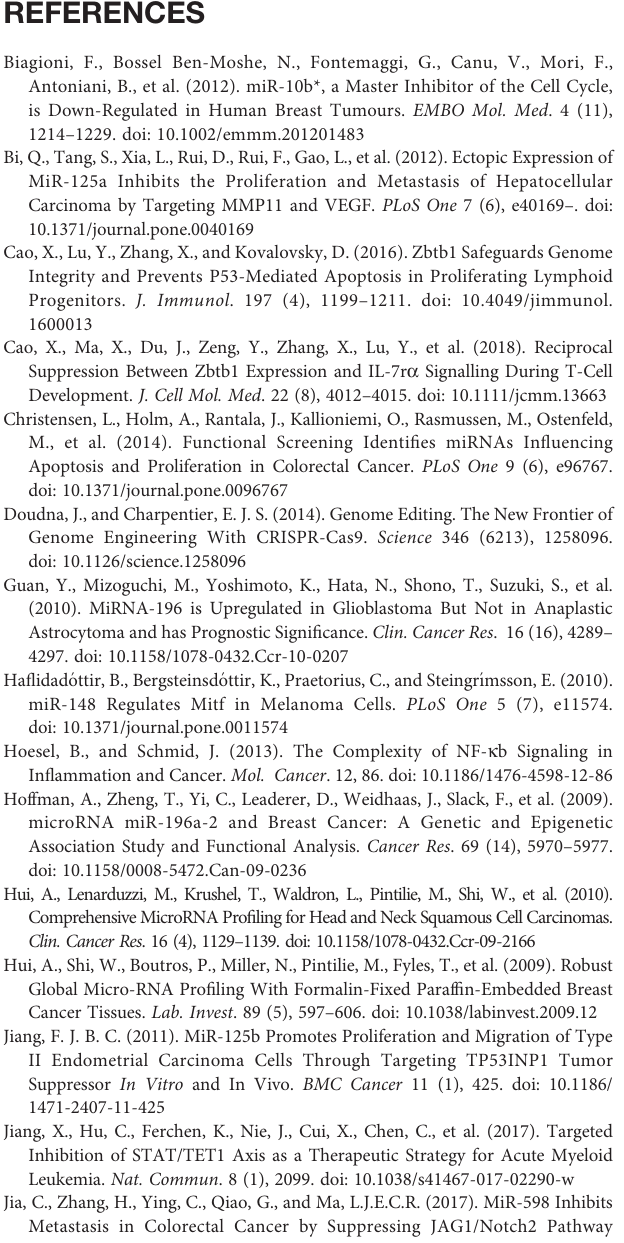
Supplementary Table 9 | Pathway of circRNA-derived genes. (1) PathwayID: pathway ID; (2) Pathway: pathway name of circRNA source genes; (3) DEGs with pathway annotation: number of genes in the difference analysis comparison group; (4) All genes with pathway annotation: the number of genes in all gene backgrounds; (5) P-value: this pathway has an increased P-value; (6) Q-value: this pathway has an increased Q-value; (7) Genelist: this pathway is enriched in differentially expressed genes; (8) KOlist: this pathway is enriched in differentially expressed KO